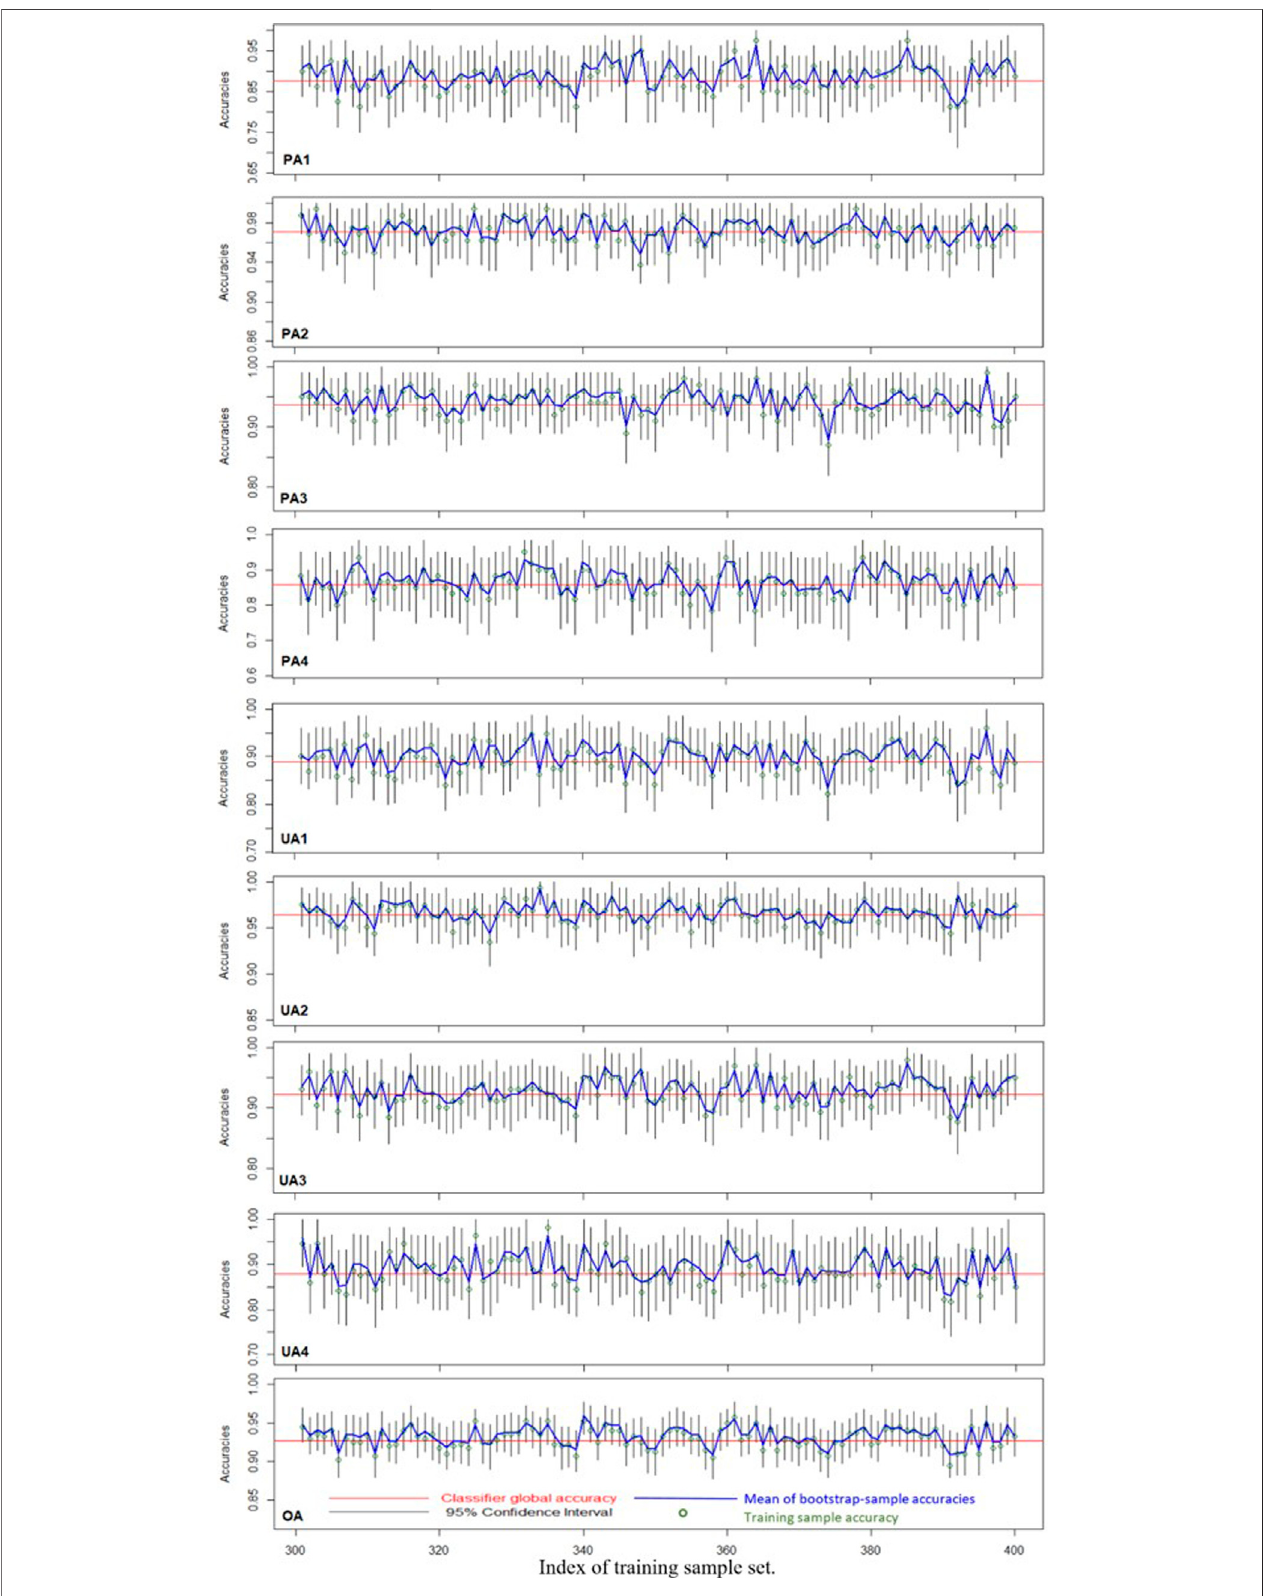
FIGURE 8 | Illustration of 95% bootstrap con fi dence intervals of different accuracy measures (4C3F case).